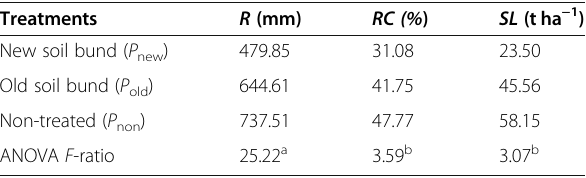
Table 2 Significance test results of runoff ( R ), runoff coefficient ( RC ), and soil loss ( SL ) between plots with different treatments Treatments